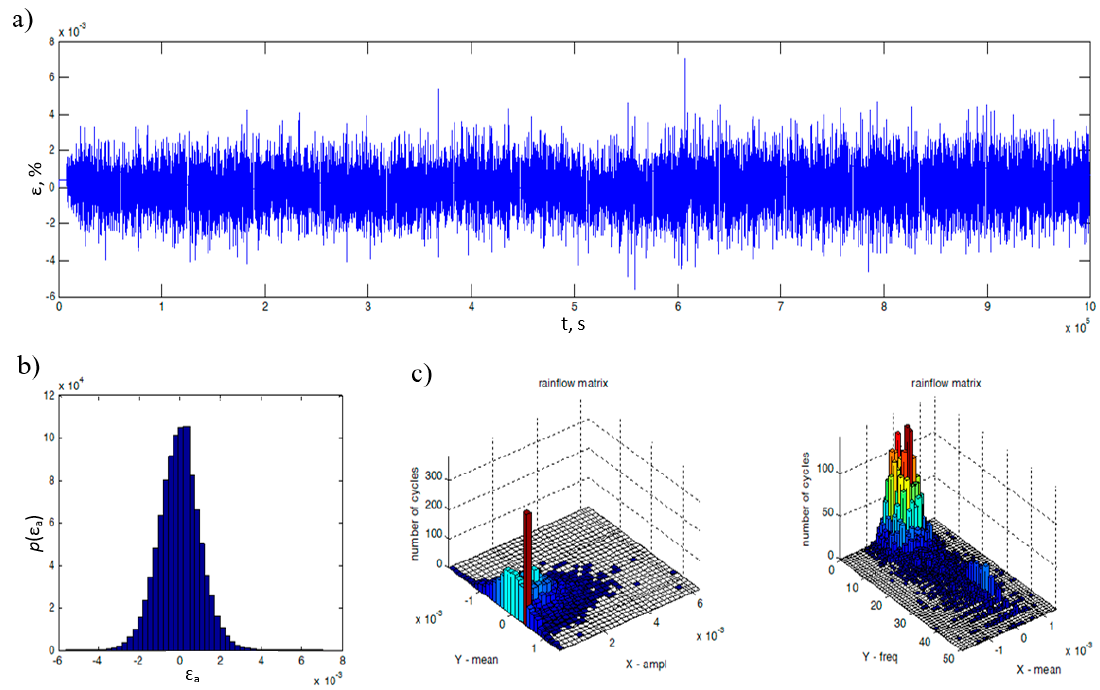
Figure 8. A fragment of the deformation process registered with the strain gauges ( a ), distribution of deformation amplitudes ( b ), and its characteristics due to matrices counted by the rainflow method ( c ).